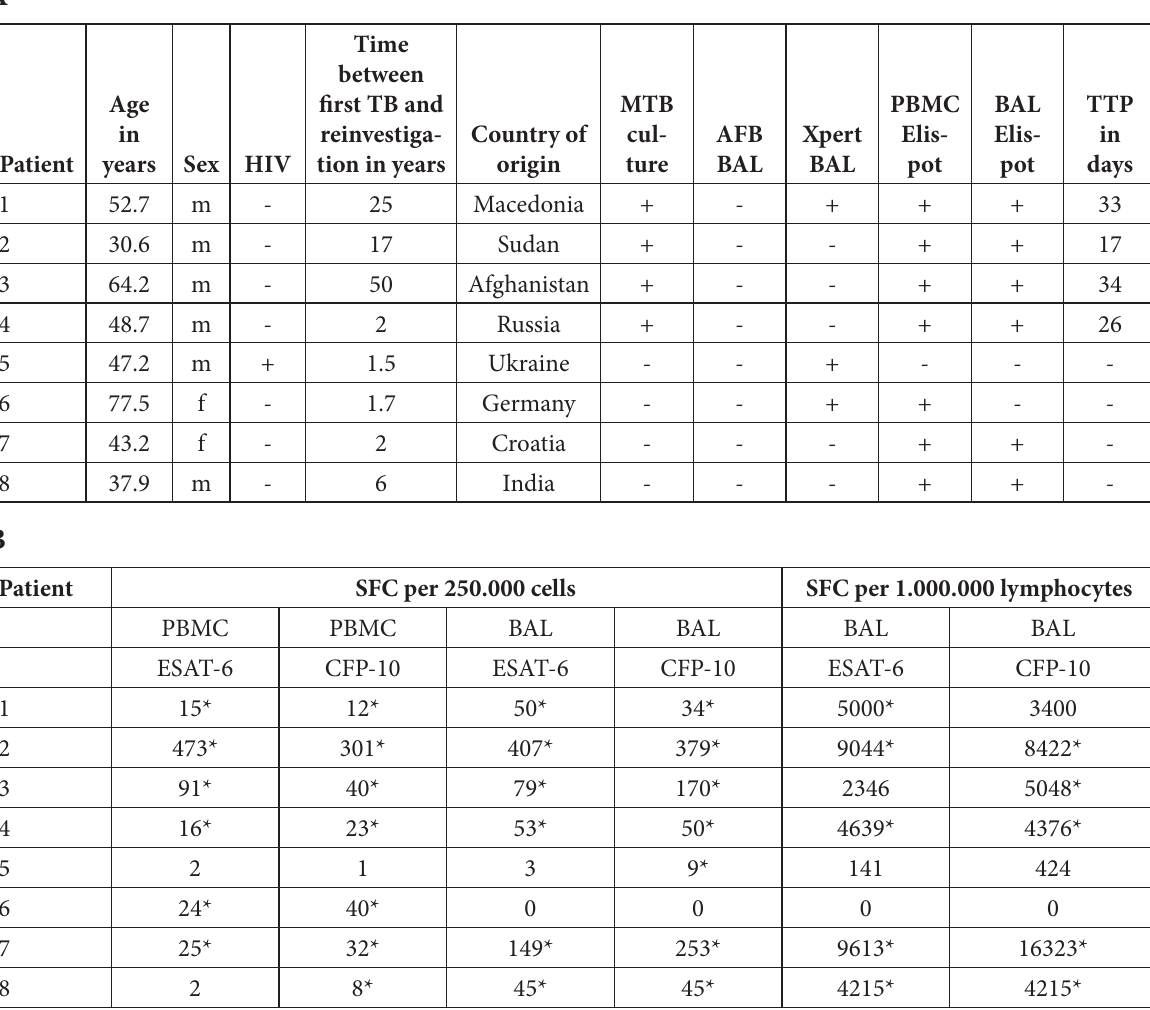
Table 1. Characteristics of Patients with 1 or More Positive Tests (>4,000 BAL lymphocytes) (ELISPOT, BAL-GeneXpert,